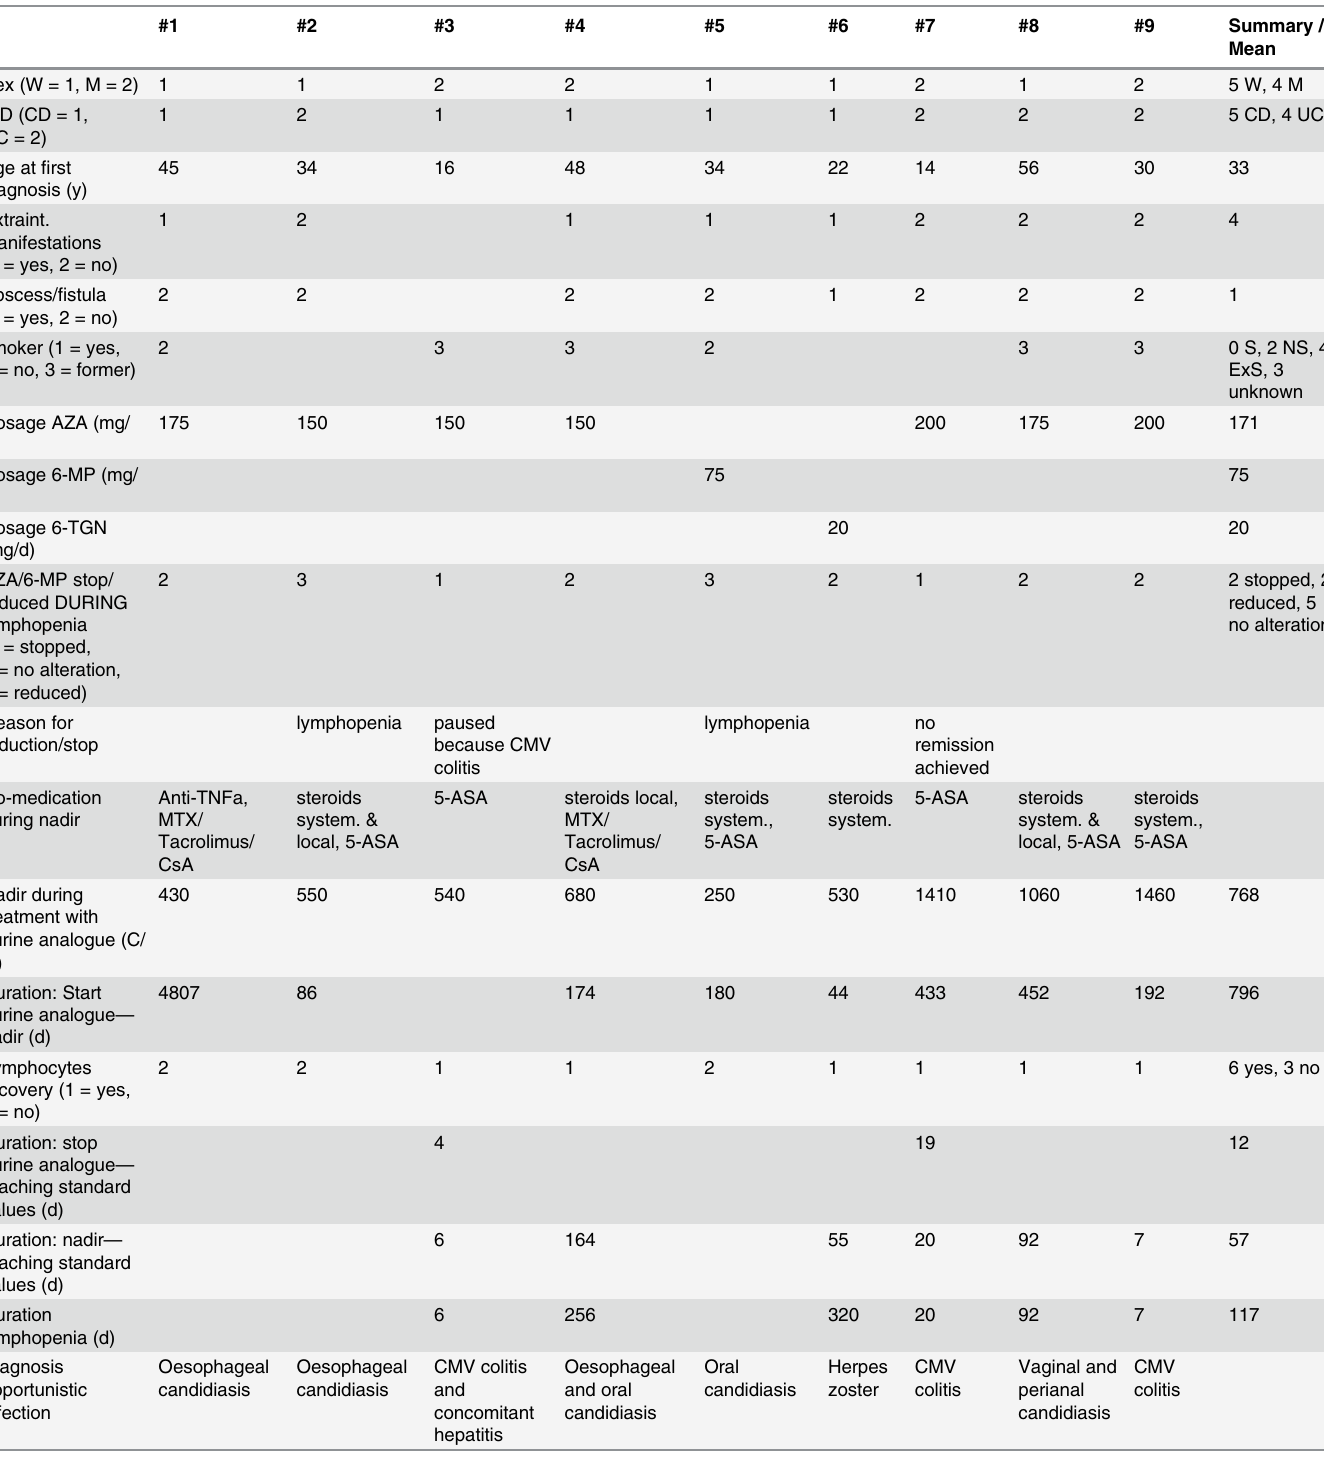
Table 6. Details of opportunistic infections during